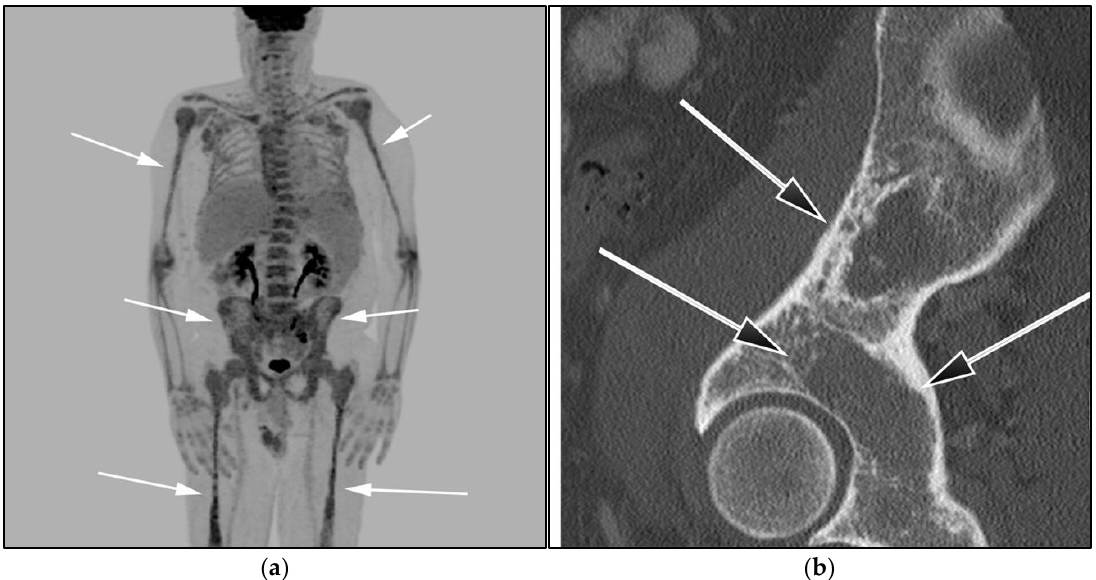
Figure 11. A 85-year-old-male with known diagnosis of lymphoplasmacytic lymphoma (LPL). ( a ) Maximal intensity projection (MIP) FDG PET/CT image shows extensive hypermetabolic uptake within the spine, pelvis, and proximal upper and distal appendicular skeleton (white arrows). This patient had not received recent marrow stimulating drugs, which can produce imaging findings consistent with marrow infiltration ( b ). A sagittal CT image shows diffuse osteopenia, marrow space widening, and no discrete focal lesions (black arrows). This is a very important to differentiate from myeloma, which often presents with frankly lytic lesions.